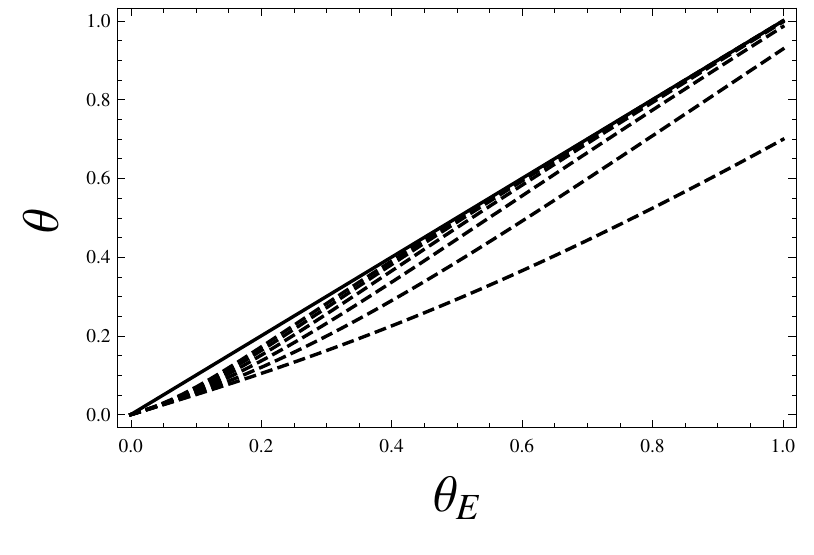
D < 10 (dashed 2 OL